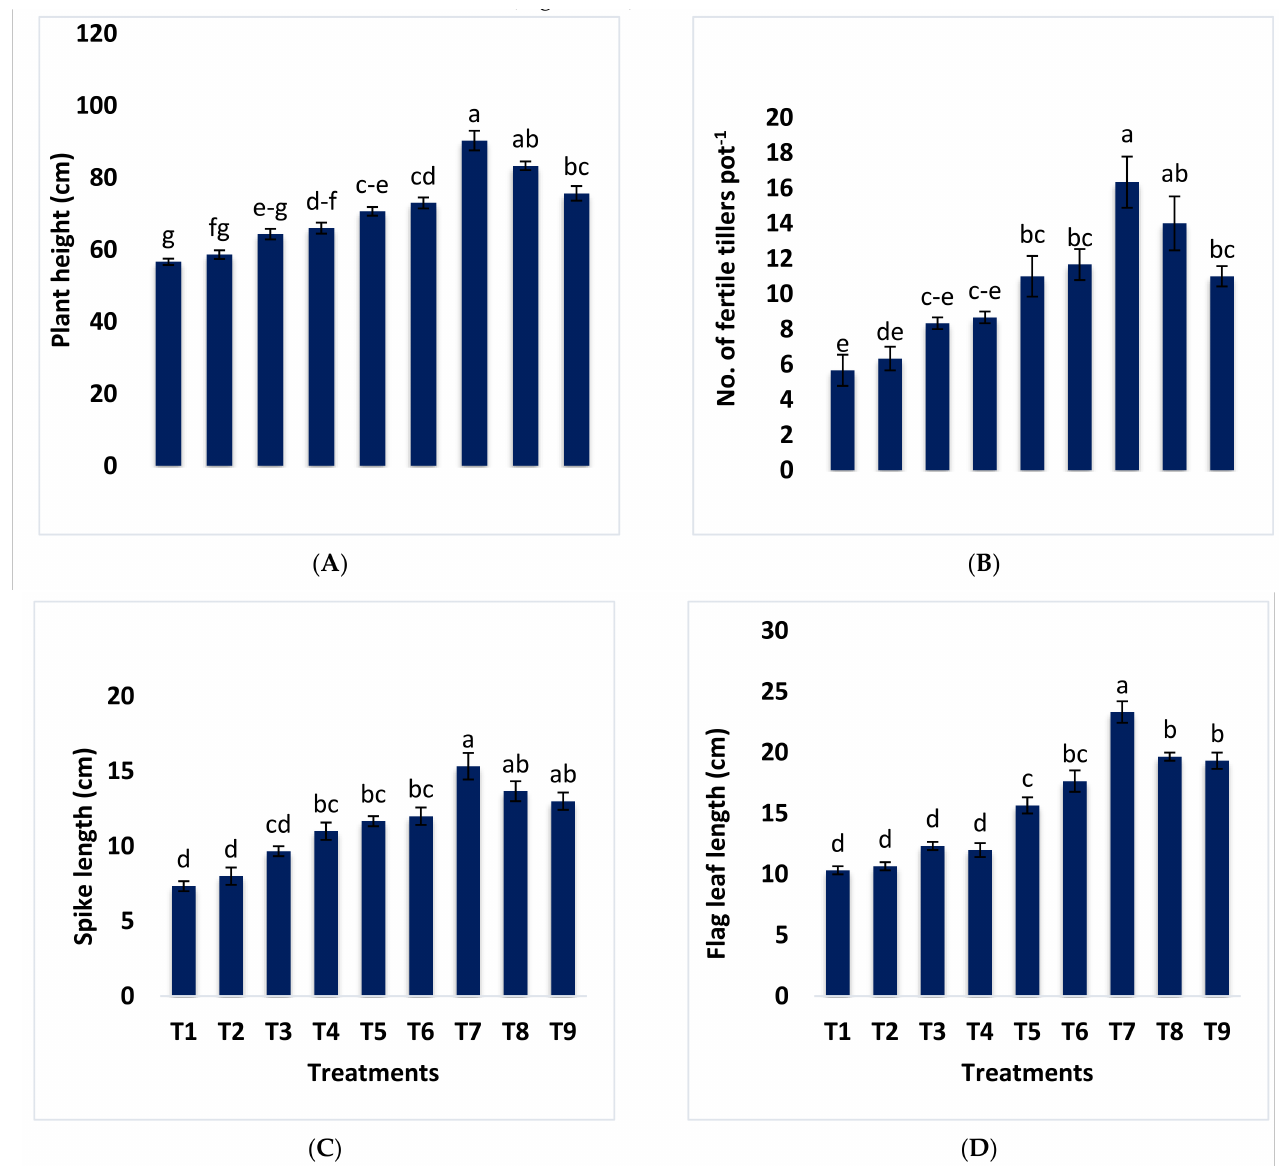
Figure 1. Effect of different combinations of B-RP and DAP on plant height ( A ), no. of tillers ( B ), spike length ( C ) and flag leaf length ( D ) of wheat. Bars sharing similar letters do not differ significantly at P < 0.05; The standard error (SE) represents variation of population mean from sample mean ( n = 3); T1: Control (0% P), T2: RP (100% P), T3: AM (100% P), T4: PM (100% P), T5: B-RP (100% P), T6: B-RP (75% P) DAP (25% P), T7: B-RP (50% P) + DAP (50% P), T8: B-RP (25% P) + DAP (75% P), T9: DAP (100% P). RP: Rock phosphate, AM: Animal manure, PM: Poultry manure, B-RP: Bio-activated rock phosphate, DAP: Diammonium